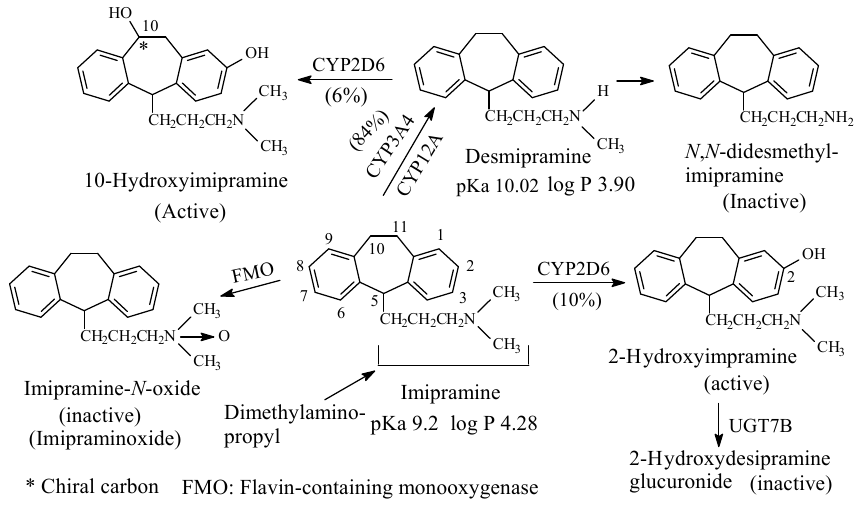
Figure 3. Metabolic pathways of imipramine.